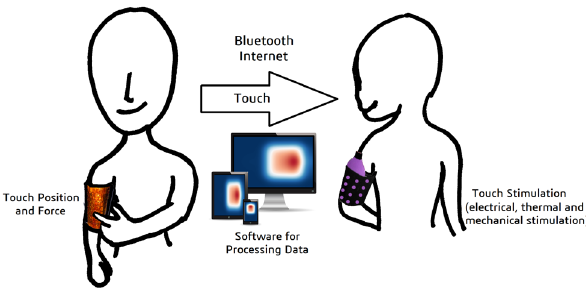
Figure 1: Concept of the TouchYou. A pair of touch - sensitive and touch - stimulation interfaces enable the touch communication over the